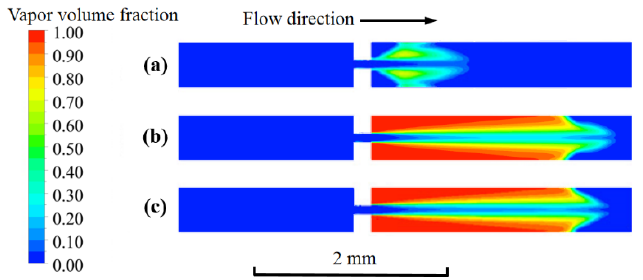
Figure 3. The vapor fraction at the cross-section z = 0.1 mm of the micro-channel, ( a ) Grid 158,730 cells; ( b ) Grid 335,223 cells; and, ( c ) Grid 484,290 cells.